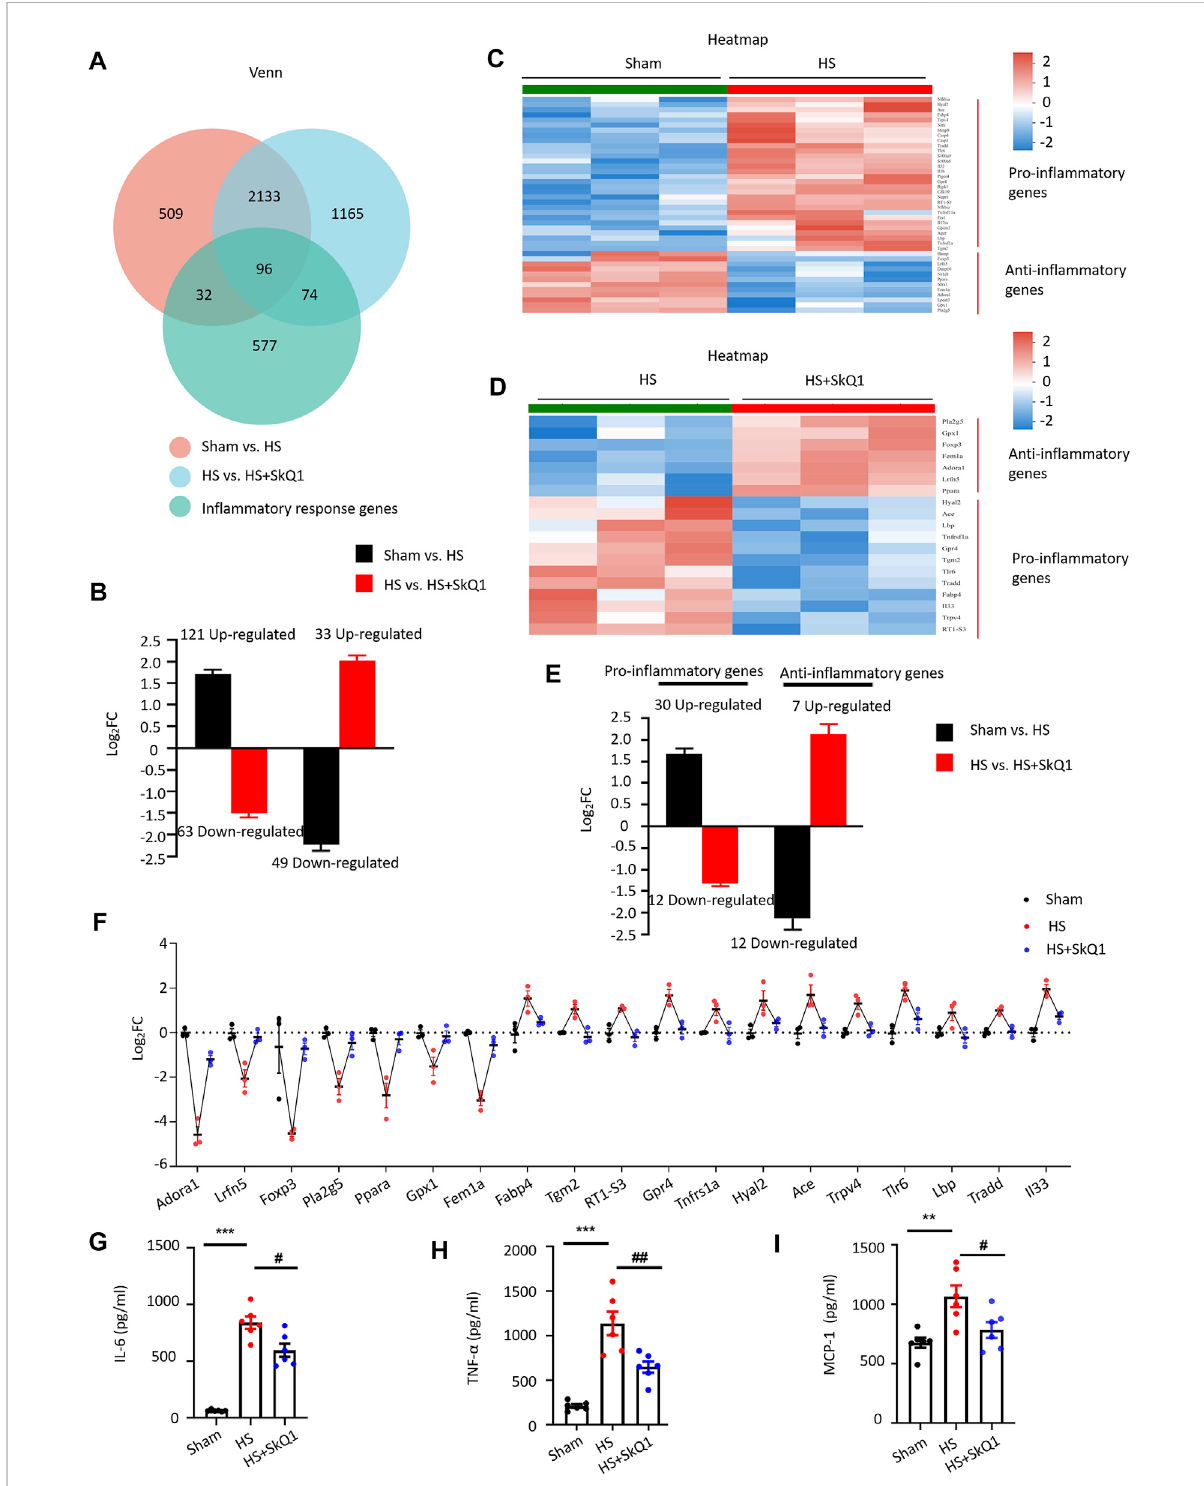
FIGURE 6 SkQ1improvesin fl ammatoryresponseafterHS. (A) Venndiagramofthein fl ammatoryresponseDEGsintheshamvs.HSandintheHS+vehicle vs. HS + SkQ1 group; the expressions of 96 in fl ammatory genes were reversed by SkQ1. (B) Statistical results of the average expression of in fl ammatory response genes. The black column chart shows the changes in in fl ammatory gene expression in the HS vs. sham group. The red column chart shows the changes in in fl ammatory gene expression in the HS + SkQ1 vs. HS + vehicle group; n = 3 mice per group; log 2 FC >